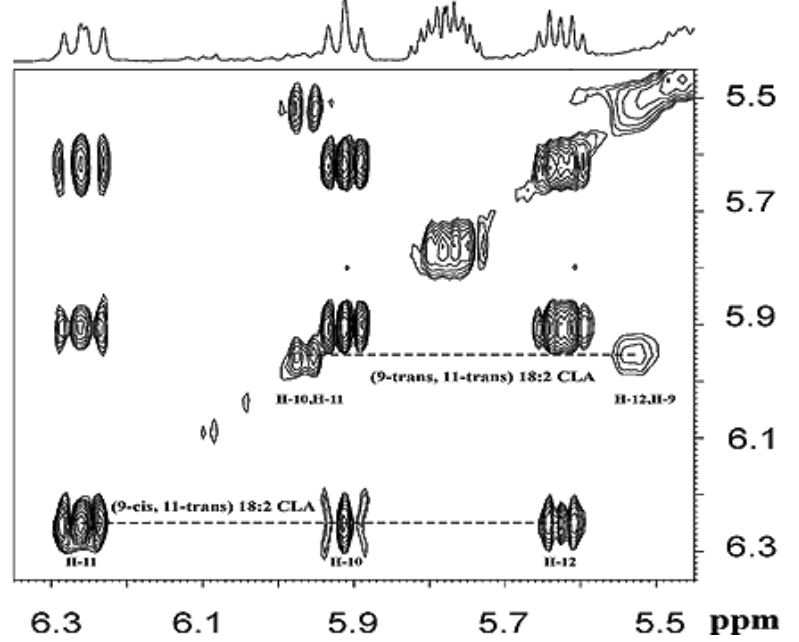
Figure 26. 500 MHz 1 H- 1 H TOCSY NMR spectrum of the lipid fraction of a lyophilized milk sample in CDCl 3 with suppression of two major lipid proton resonances at 1.27 and 5.35 ppm. Experimental conditions: 298 K, 32 repetitions of 256 increments, total experimental time 5 h 5 min. Adopted, with permission, from [56]. Copyright 2014, Elsevier B.V.